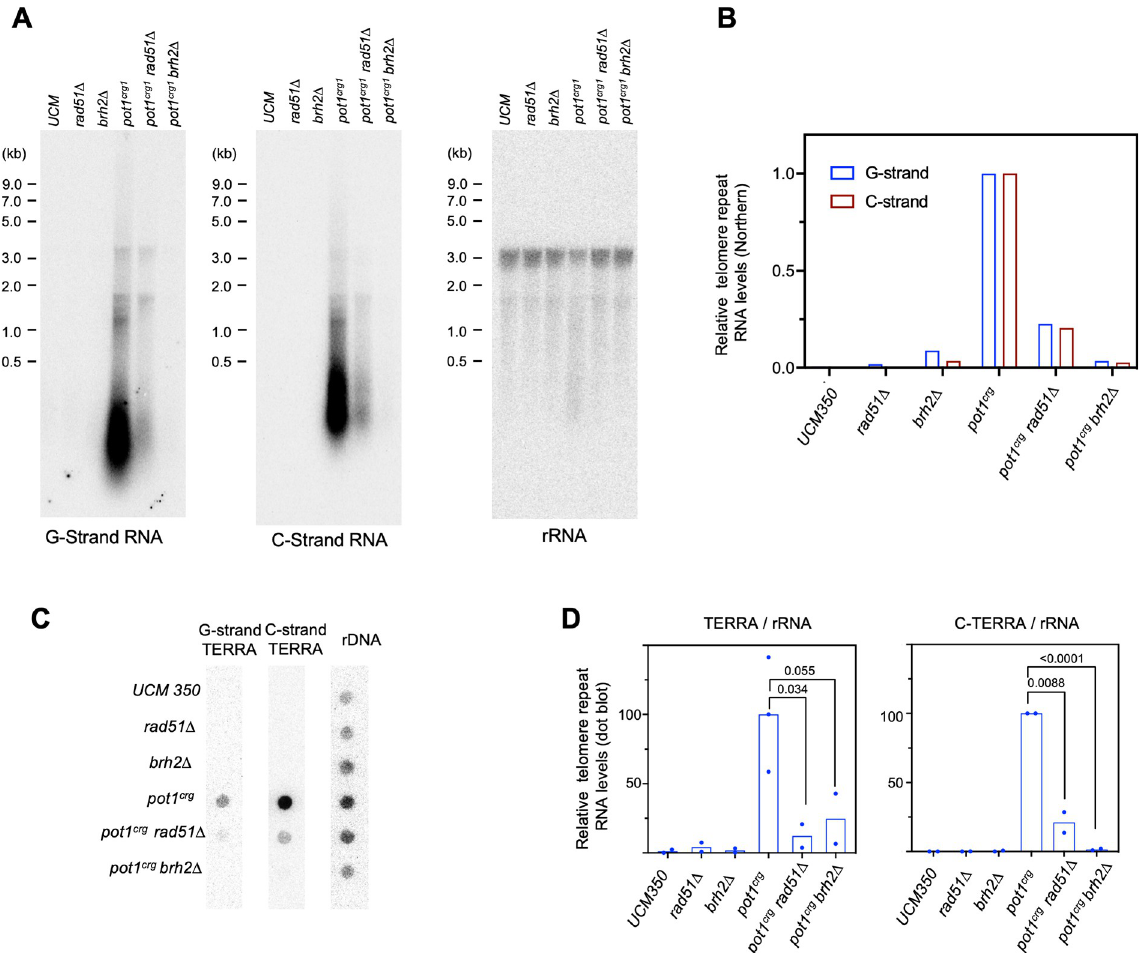
Fig 6. Telomere repeat-containing RNAs are elevated by pot1 -deficiency and suppressed by rad51 Δ and brh2 Δ . A. RNAs from the indicated wild type and mutant strains grown in YPD were isolated by acid phenol extraction and subjected to Northern analysis using sequentially probes that detect G-strand repeats, C-strand repeats, and 26S rRNA. B. The ratios of G- and C-strand RNA signals to the 26 rRNA signals from Northern analysis were calculated, and then normalized against the ratio of the pot1 crg1 mutant and plotted. The normalized values for the pot1 crg1 G- and C-strand RNA levels were each set to 100. C. RNAs from the indicated wild type and mutant strains grown in YPD were isolated by acid phenol extraction, treated with Turbo DNase (Thermo Fisher Inc.), and subjected to dot blot analysis using sequentially probes that detect the G-strand repeats, C-strand repeats, and 26S rRNA. D. The ratios of G- and C-strand signals to the 26 rRNA signals from dot blot analysis (n = 2 or 3) were calculated, and then normalized against the ratio of the pot1 crg1 mutant and plotted. P-values were calculated using two-tailed Student’s t tests and